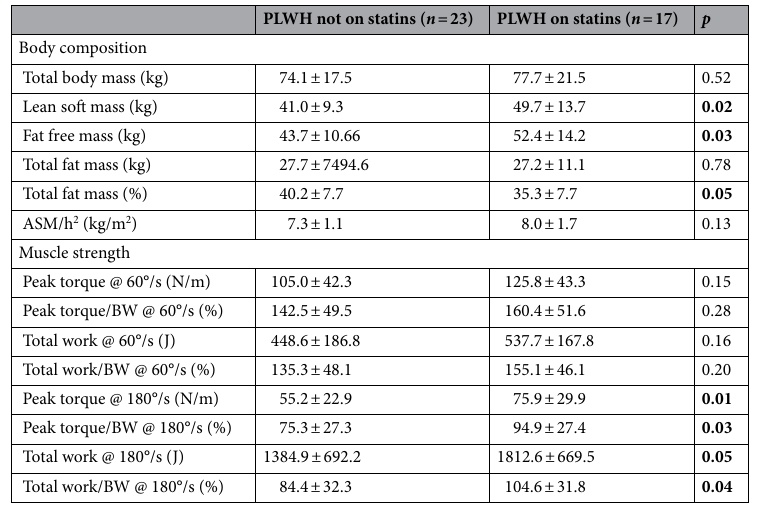
Table 3. Body composition by dual-energy X-ray absorptiometry scanning and muscle strength by isokinetic dynamometry measured in people living with HIV on and not on statins. Values are expressed as mean ± standard deviation. PLWH people living with HIV, ASM/h 2 appendicular skeletal muscle mass index, BW total body mass. Significant values are in